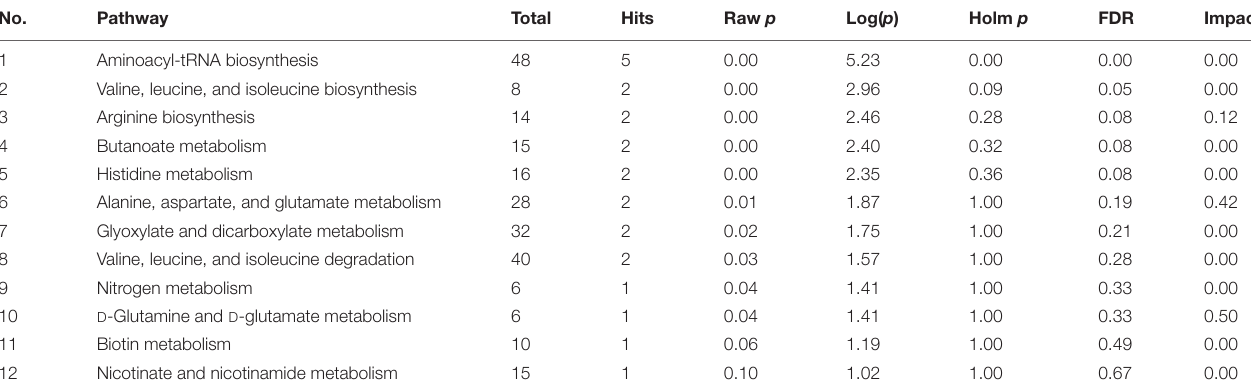
FIGURE 7 | Effect of ZBPYR on the composition of metabolites in the hippocampus of rats. (A) Global metabolite analysis based on PCA score plots. (B) Global metabolite analysis based on PLS-DA score plots. (C) Composition of metabolite classes analysis. (D) Differential metabolites in hippocampus. (E) Diagram of metabolic enrichment pathways. n = 7 per group. * p < 0.05, ** p < 0.01, *** p < 0.001. PCA, principal component analysis; PLS-DA, partial least squares discriminant analysis. TABLE 2 | Metabolite pathway changes in